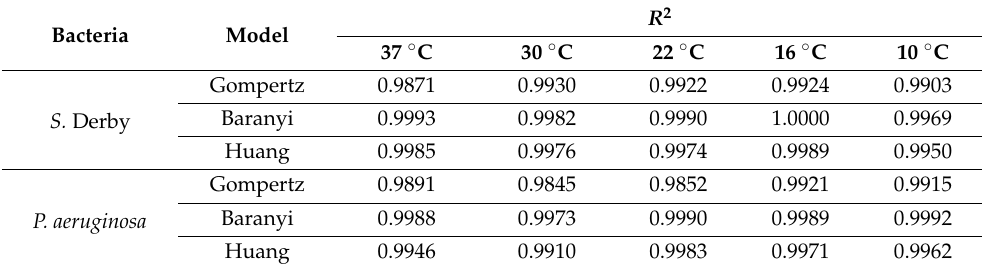
Table 1. Decisive coefficient ( R 2 ) of fitting curve of each